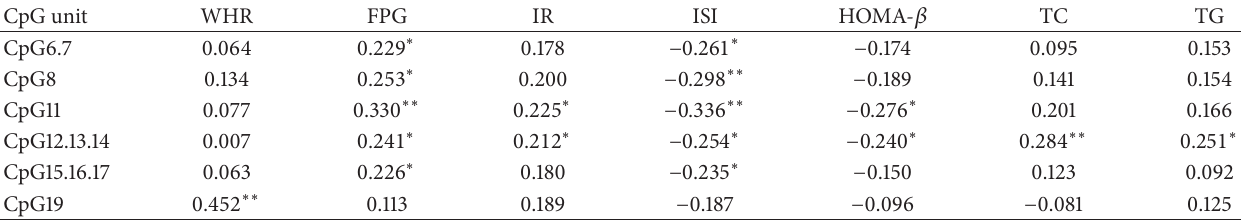
Table 2: Correlation between methylation units and clinical